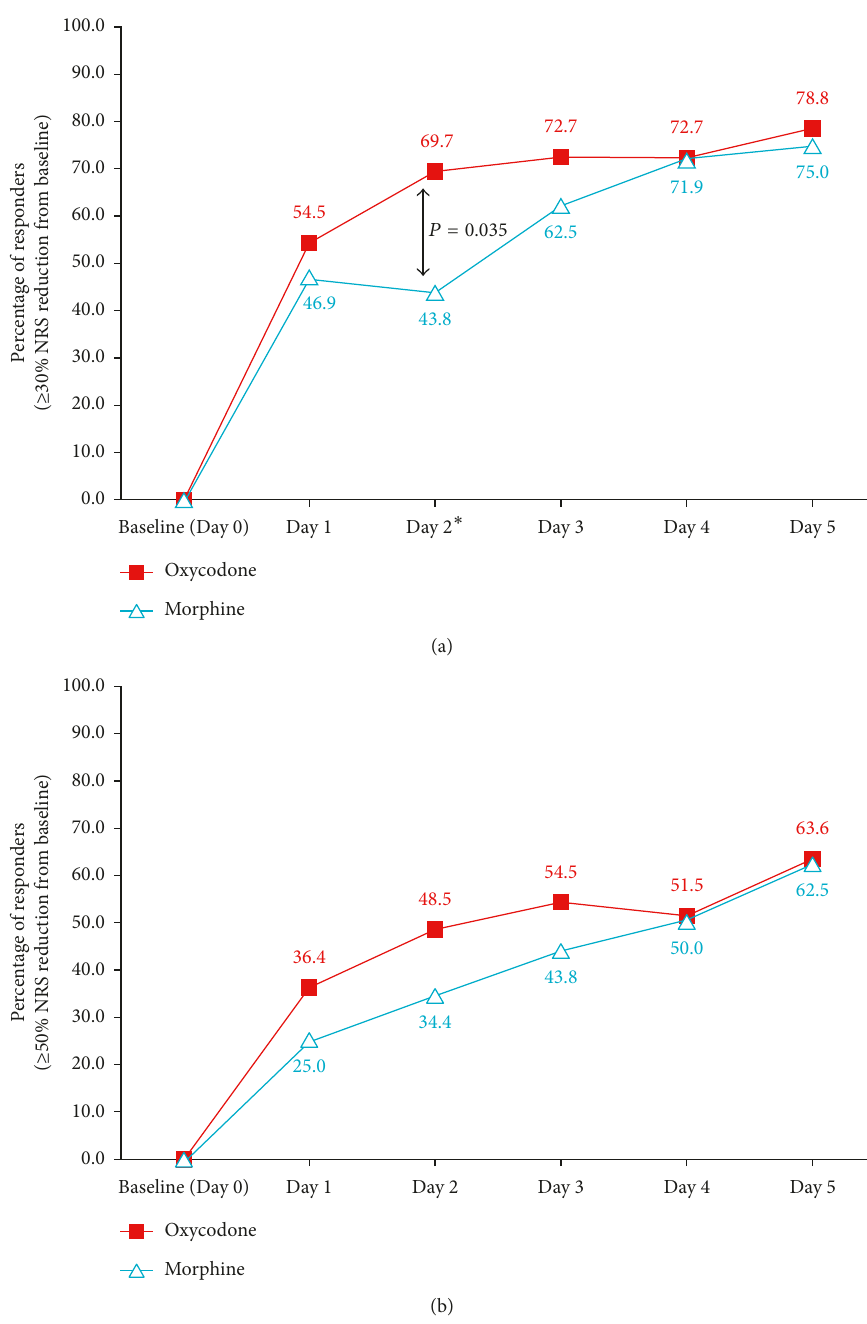
Figure 4: Percentage of responders based on (A) responders is significant. NRS (cid:30) Numerical Rating